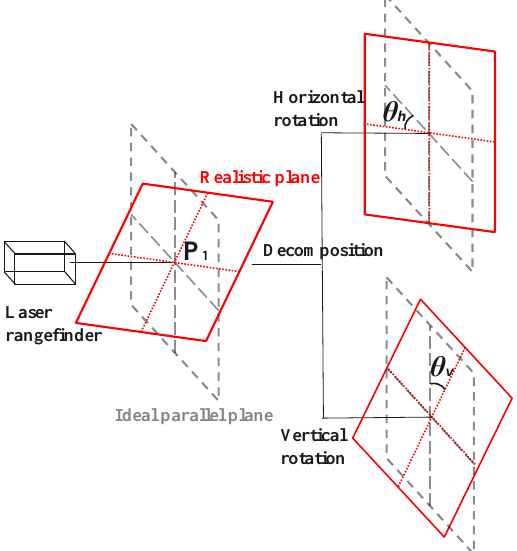
Figure 4. Decomposition of unparallel plane into horizontal and vertical orientation.